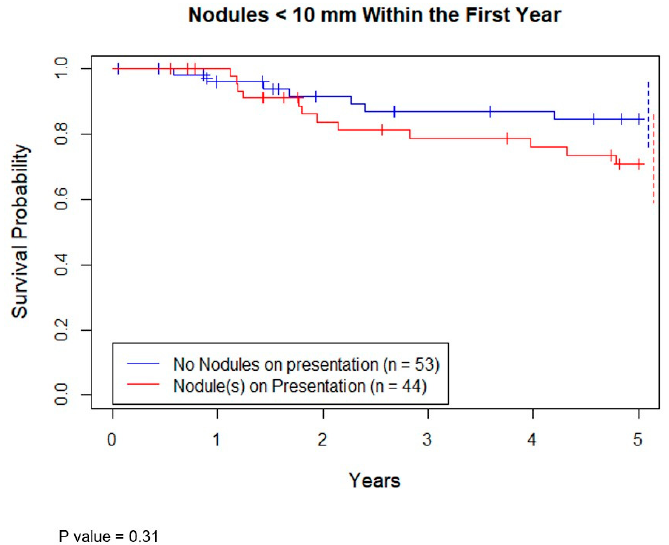
Figure 2. Kaplan–Meier curve demonstrating survival probability vs. years. Groups are separated by presence of a nodule < 10 mm on presentation and those who did not have any nodules on presentation. Dotted lines represent 95% confidence intervals for respective color.